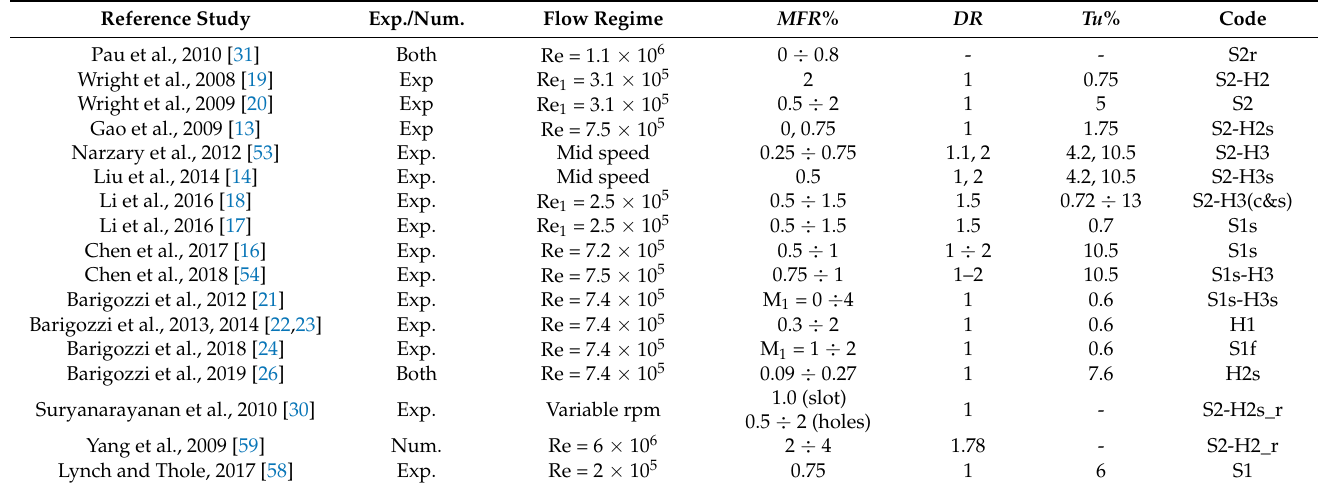
Table 4. Summary of considered literature—thermal